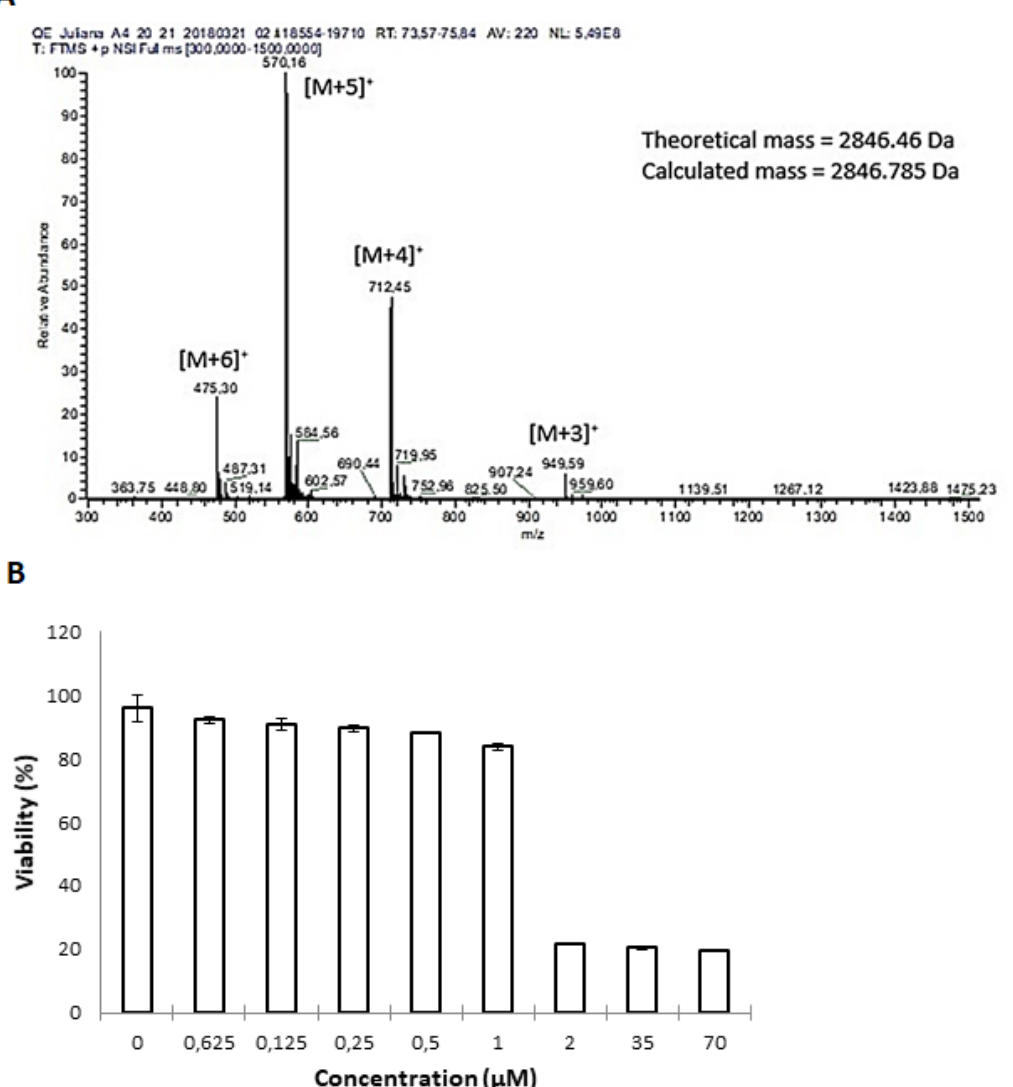
Figure 1. Characterization of melittin used in the CRC treatment. (A) Mass spectrometry analysis showing purity and molecular mass of the peptide. (B) MTT assay with antiproliferative results of melittin on HT-29/carcinoma colon in vitro (mean ± SD). The dose-response relationship demonstrates the effect with increasing dose levels (p < 0.05), which reached its maximum with 2 µM resulting in 80%